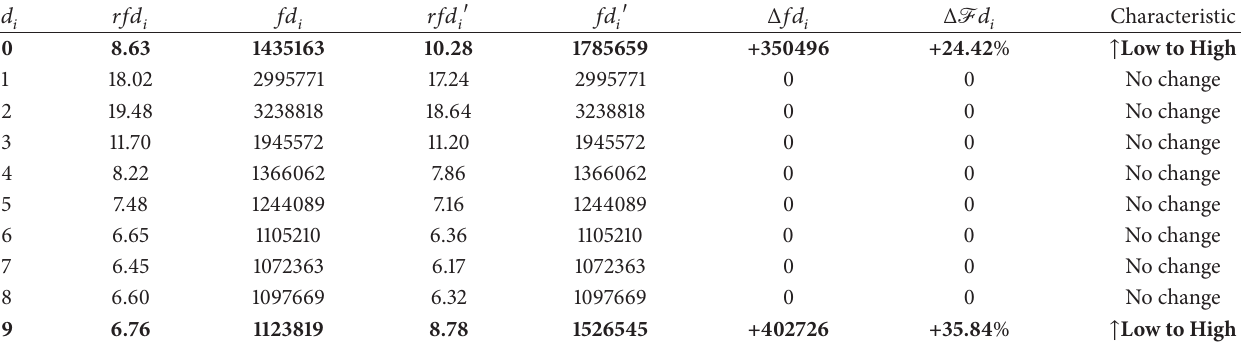
Table 6: Characterization of malicious insertion attacks on digit frequency.